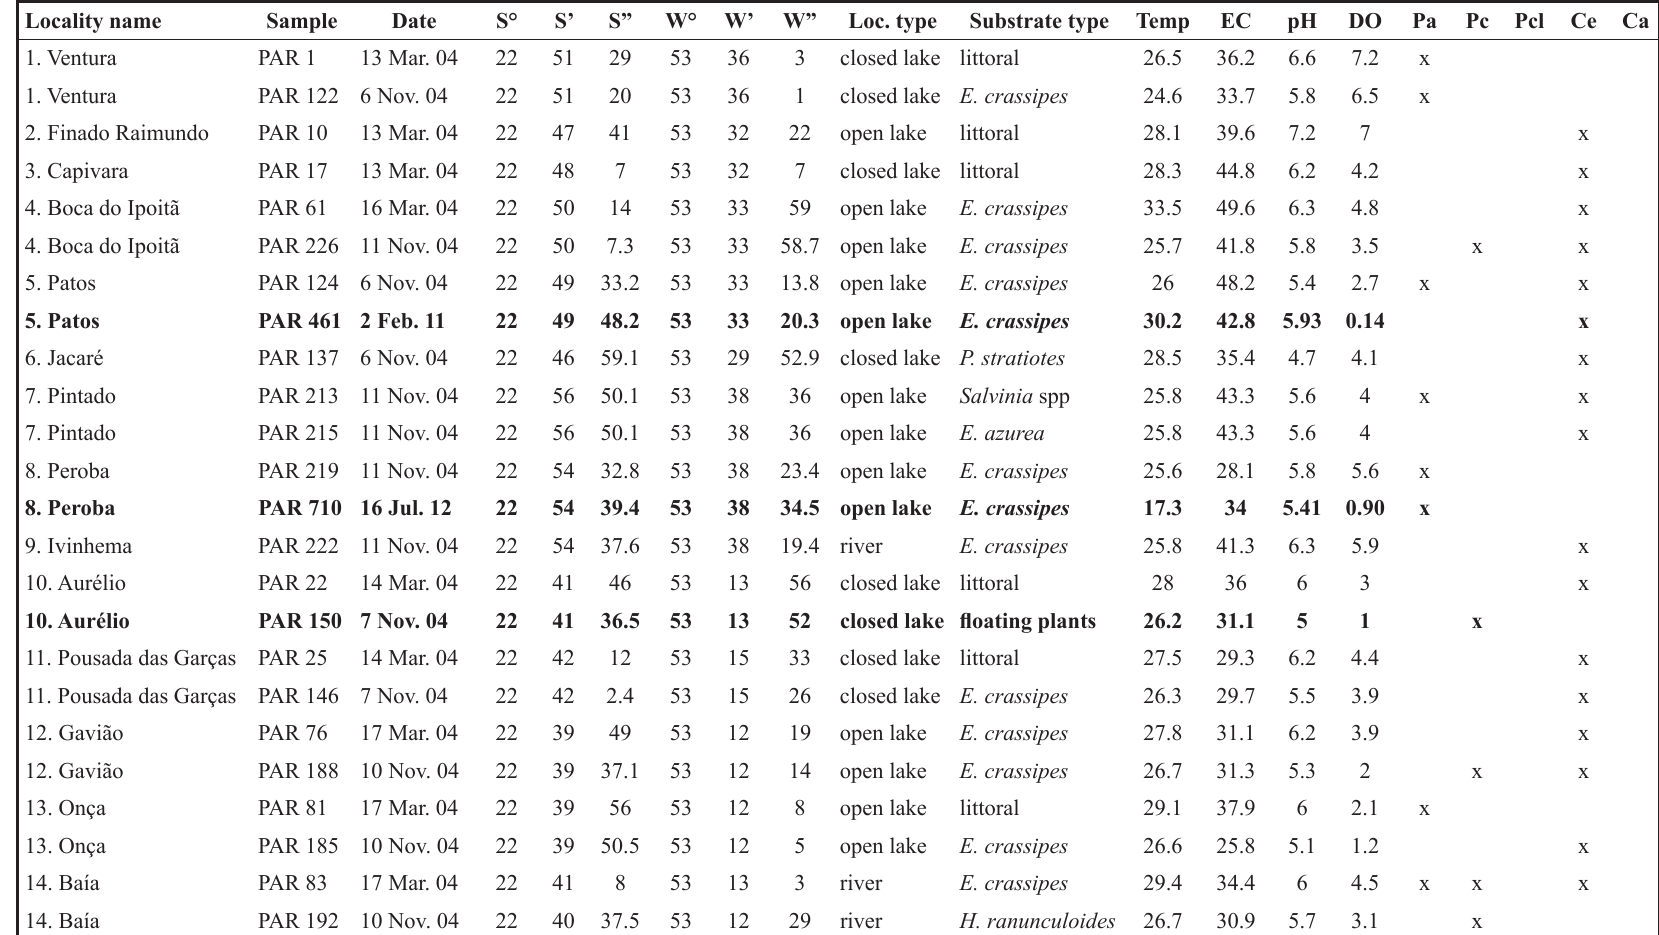
Table 1. Localities (and some of their characteristics) from which the five new species of candonids were collected. Locality names of 1 to 9 are from the Ivinhema River System, 10 to 18 from the Baía River System, 19 to 22 from the Paraná River System and locality 23 is from the Taquaruçu System. Bold = type localities of the new species. WT = water temperature ( o C), EC = electrical conductivity (µS cm -1 ), DO = dissolved oxygen (mg L -1 ), Pa